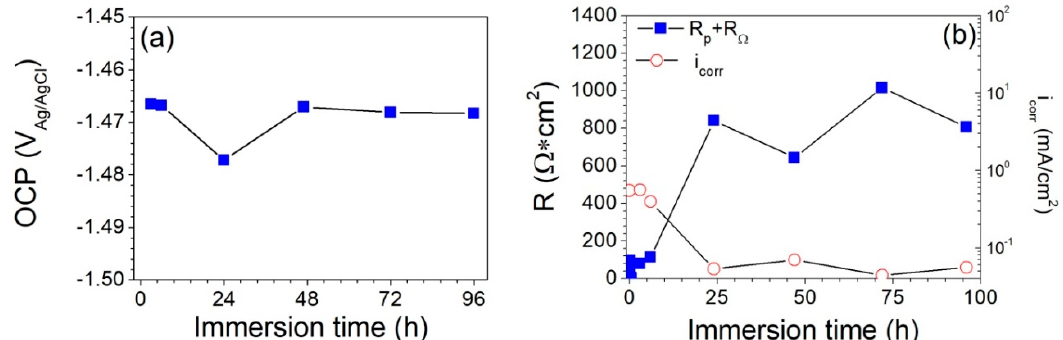
Figure 9. Linear polarization curves of EZ51-IM350 of freshly prepared specimen immediately after immersion and the specimen immersed in PBS solution during 48 h. Tafel fittings at ± 100mV OCP are also depicted.